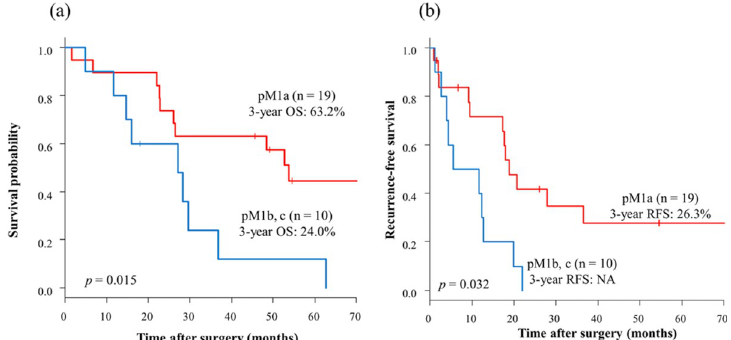
Fig 3. Kaplan-Meier overall survival (a) and recurrence-free survival (b) curve for patients with each M-category pM1a and pM1b, c. The 3-year OS rate in the pM1a group was significantly better than that in the pM1b and pM1c groups (63.2 and 24.0%, respectively) (Fig 3A). In addition, the 3-year RFS rate was significantly different in the pM1a group and the pM1b and pM1c groups (26.3 and 0.0%, respectively) (Fig 3B). red, pM1a; blue, pM1b and pM1c. OS, overall survival; RFS, recurrence-free survival; NA, not